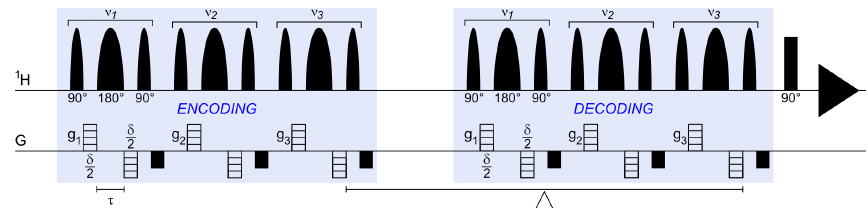
Figure 1. The selective BPP-LED (bipolar pulse paired longitudinal eddy current delay) diffusion experiment, i.e. Sel-BPP-LED. In this work, three spectral regions with centre frequency ν n were encoded. For each selective spectral region, g n were defined separately for ν 1 (water) and ν 2 , 3 (MAS peptide; Met and Ala methyl signals). Despite a hard 90 ◦ read pulse using the same phase cycle as the BPP-LED sequence, the resulting spectrum consists of only the selected spectral regions (Fig. 2). While not demonstrated in this work, diffusion encoding for each selected frequency could be uniquely defined beyond using g n by including δ n and inserting additional delays between the ν n decoding segments to vary (cid:49) n and the direction of g (where hardware permits). All parameters used this work are described in Sect.